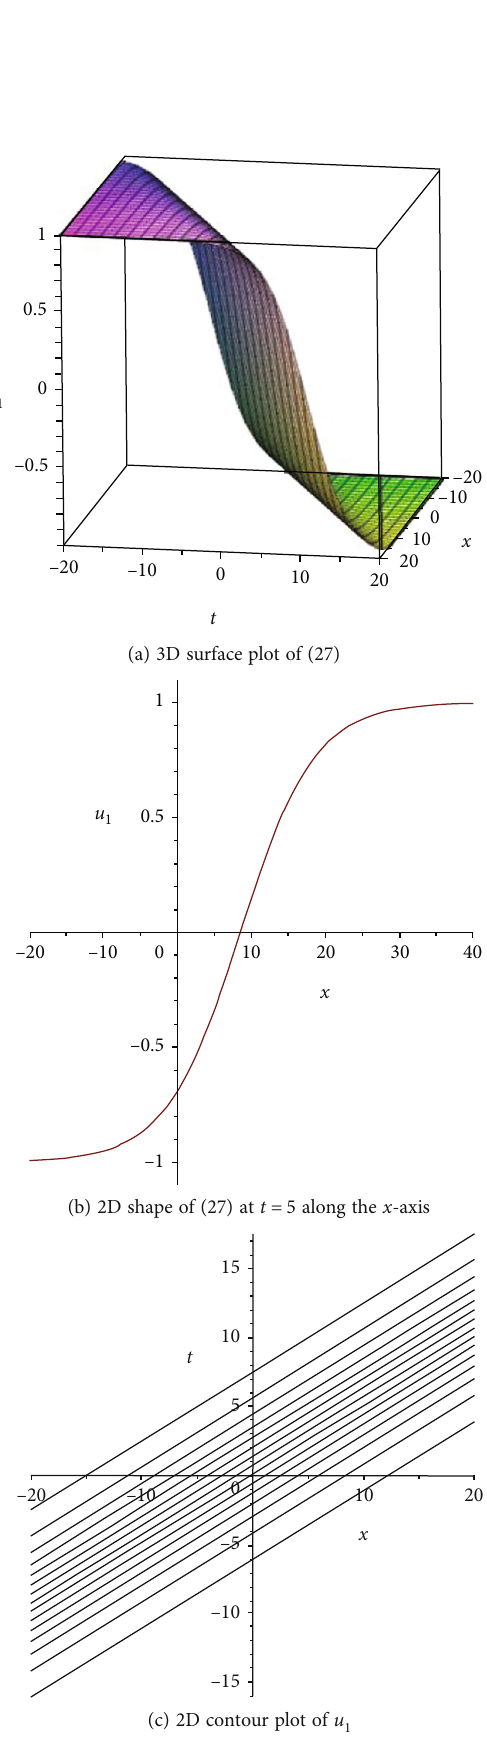
a = 0 : 1 , a = 0 : 2 , b = 0 : 24 , b 1 2 1 1 by assuming = 0 : 002 , β = 0 : 014 , σ = 0 : 0256 , σ = 0 : 0512 , y = 1 , θ = 0 , and ξ 1 2 1 2